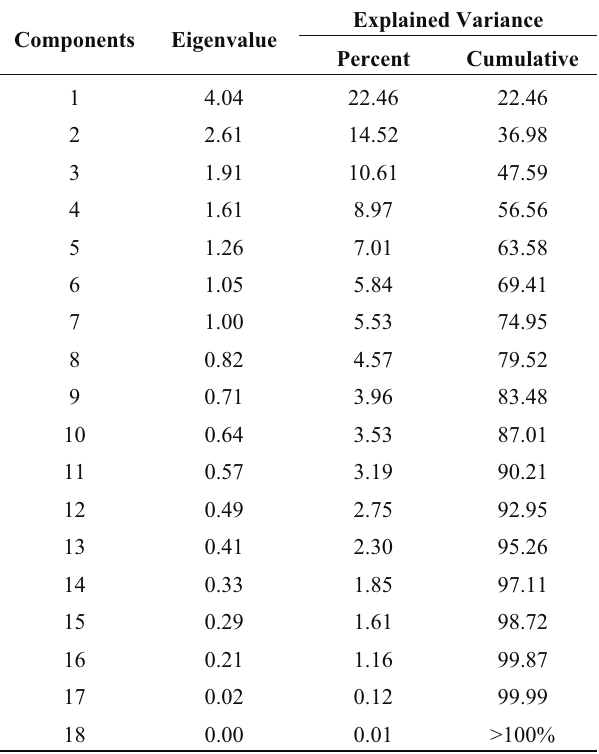
Table 3. Computed eigenvalues of the different principal components with corresponding proportion and cumulative explained variance.